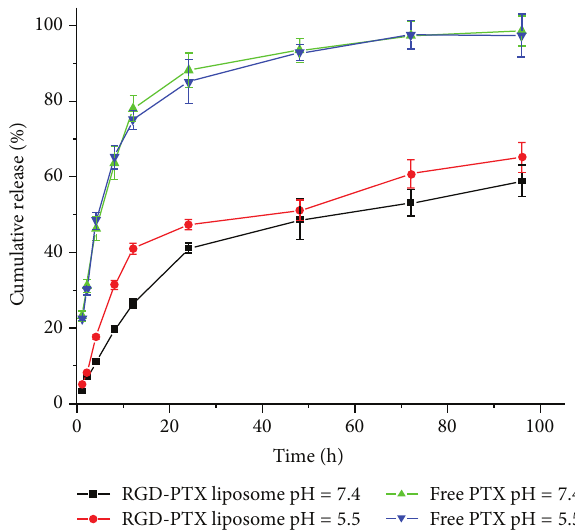
Figure 8: Drug release profiles of free PTX and RGD-PTX liposome in PBS solution at pH 7.4 and pH 5.8 with error bars showing the standard deviation ( 𝑛 = 3 ).